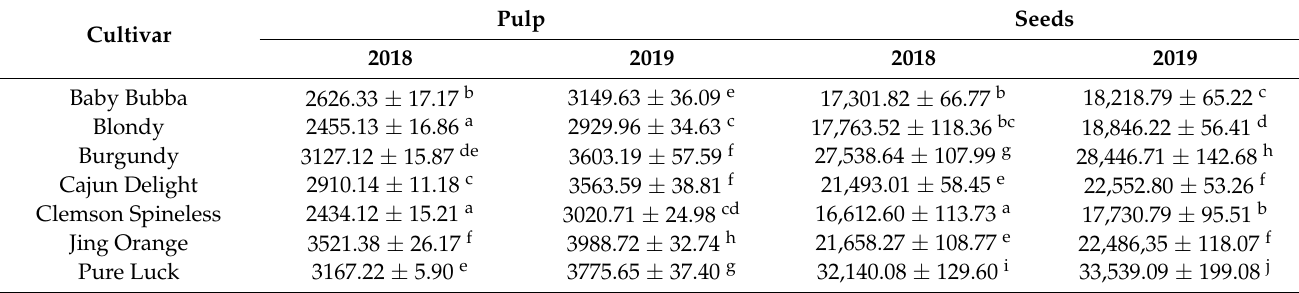
Table 5. Total polyphenol content in okra cultivars (mg GAE kg − 1